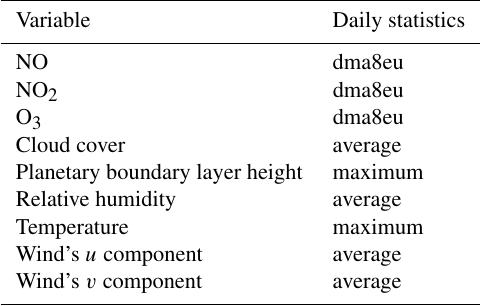
Table 2. Input variables and applied daily statistics according to Table